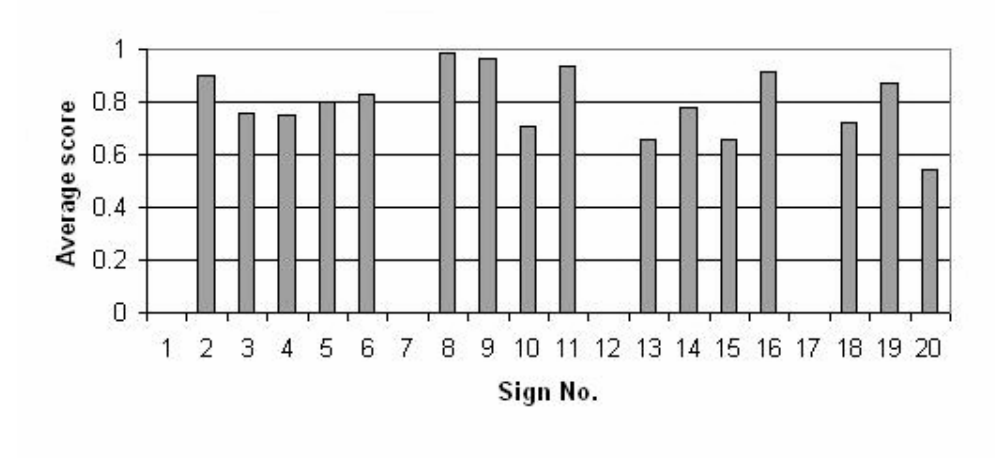
Figure 5c. Understanding of Sign